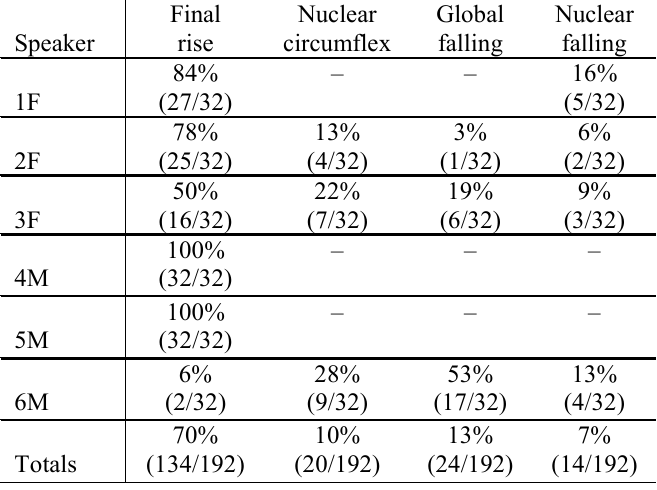
Table 1. Reading task contour